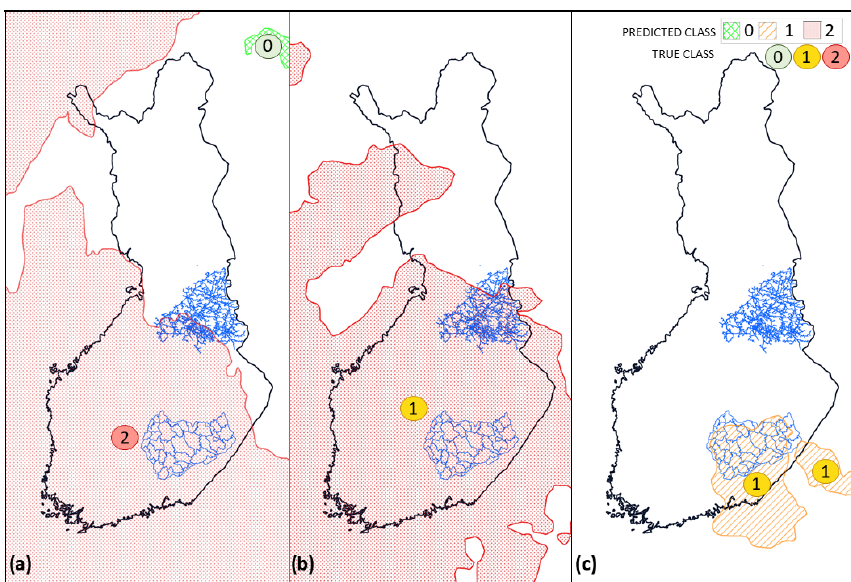
Figure 8. Selected examples. (a) Extratropical storm Tapani (26 December 2011 11:00UTC), (b) extratropical storm Rauli (27 August 2016 10:00UTC), and (c) extratropical storm Pauliina (22 June 2018 01:00UTC), produced by employing the SVC model trained with the national dataset. The storm objects are colored based on the predicted class while the true class is stated as a colored number over the